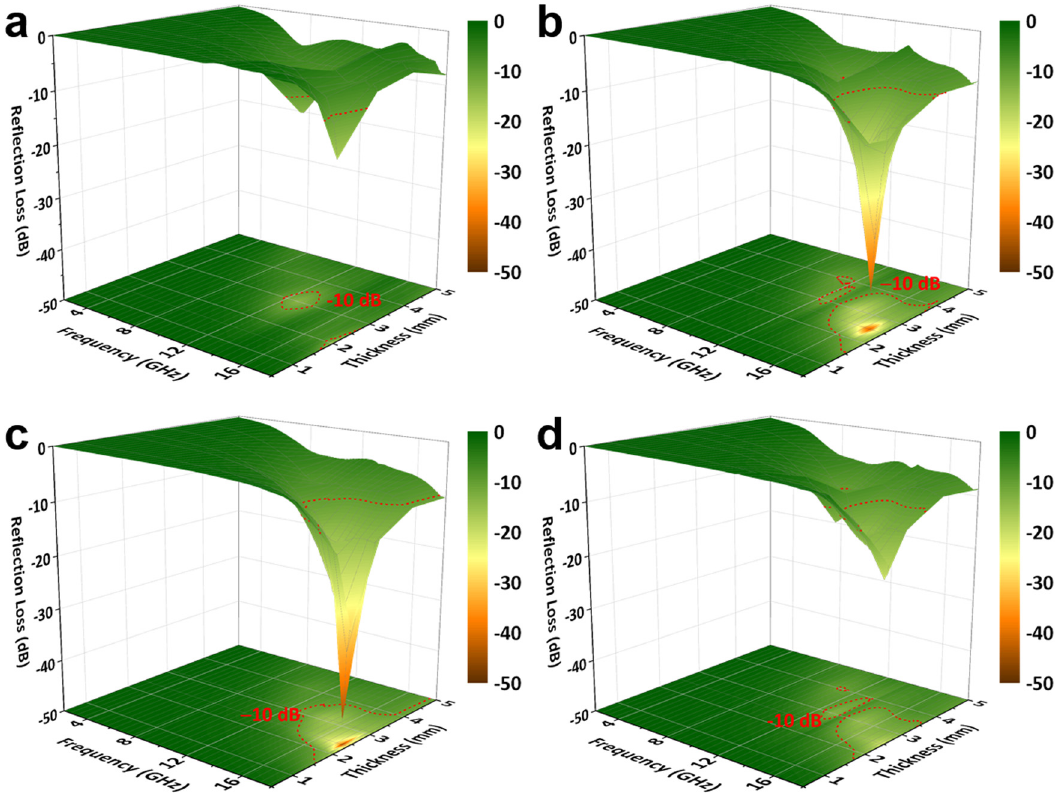
Figure 4: The calculated re fl ection loss of HCNTs. ( a ) A - HCNTs, ( b – d ) F - HCNTs - 0.5 h, F - HCNTs - 1.0 h, and F - HCNTs - 3.0 h,